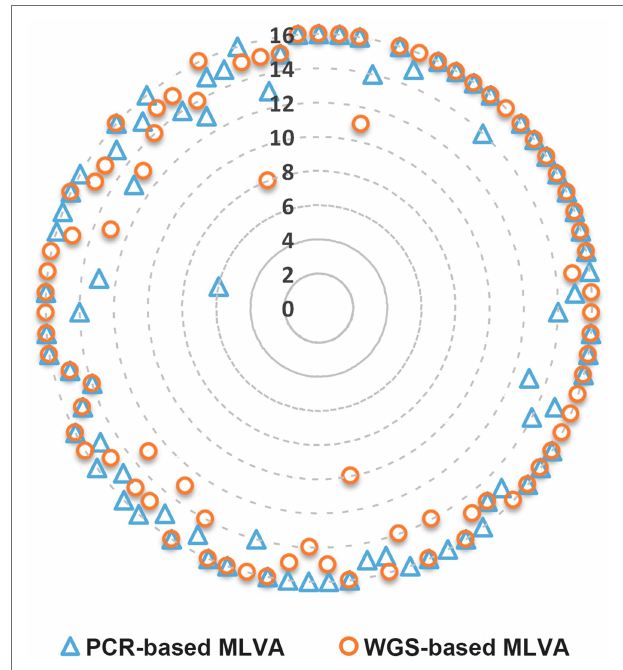
FIGURE 1 | Number of MLVA loci detected per strain through PCR- and WGS-based MLVA approaches. The data for each approach are disposed along the imaginary radius of the circle graph (one radius per strain). The WGS-based results are relative to the MLVA loci extraction using draft genomes assembled with SPAdes 3.11 (Walker et al., 2014) and subsequently improved with Pilon v1.18 (Bankevich et al., 2012) from the INNUca v4.0.1 pipeline (see methods for